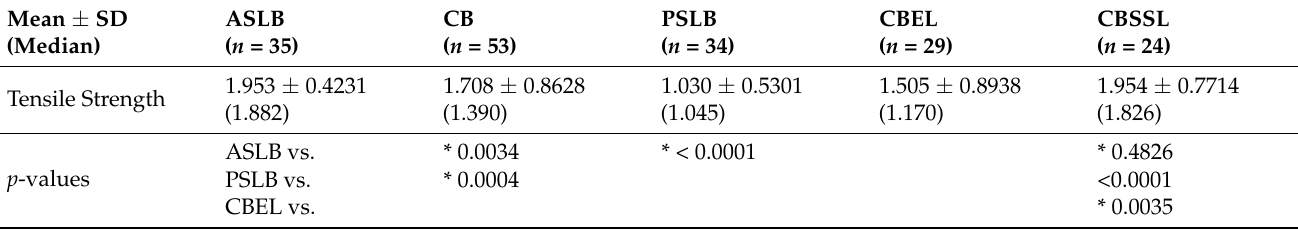
Table 5. Means and SD—tensile strength.